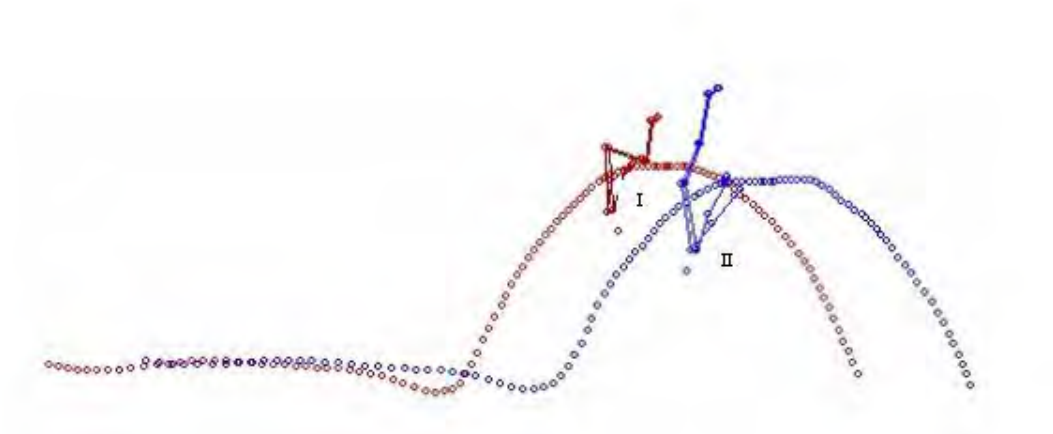
Fig. 3. Phase of main movements of acrobats, who fulfill first somersault at ascending part of flight trajectory in structure of double somersault, Key element of sport technique – MP “grouping” (tested A, variant 1, time 1. 033 sec.), and MP “arching with insignificant bending in hip joints (tested B, variant 2, time 0. 917 sec.) In variant 1 acrobat A groups tightly, in variant 2 acrobat B takes slightly arched body position to keep speed of rotation in order to ensure uninterrupted passing to second somersault in structure of double somersault (see fig. 4, 5, 6).